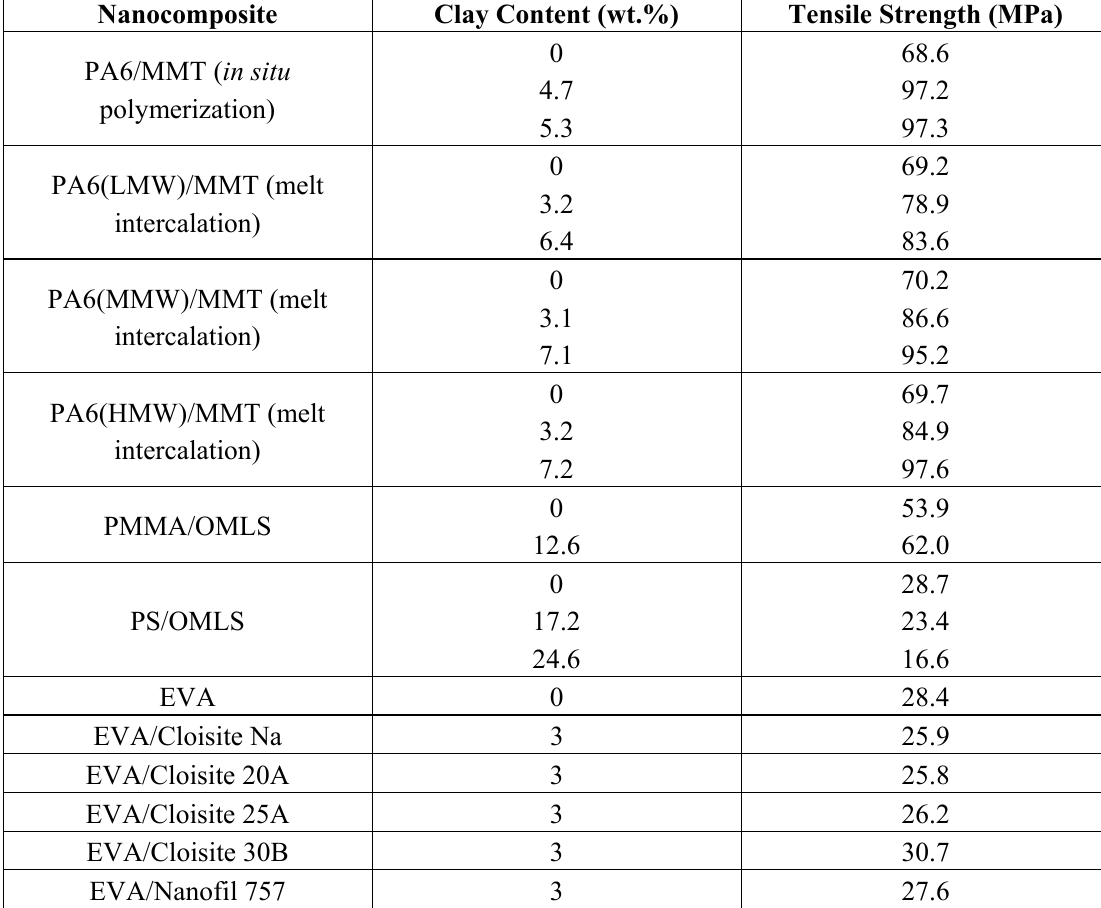
Table 3. Tensile strength values of various polymer nanocomposite systems. Reproduced from reference [4] with permission from